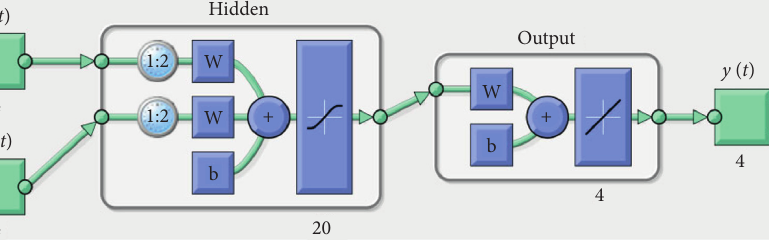
Figure 24: The designed NARX model.